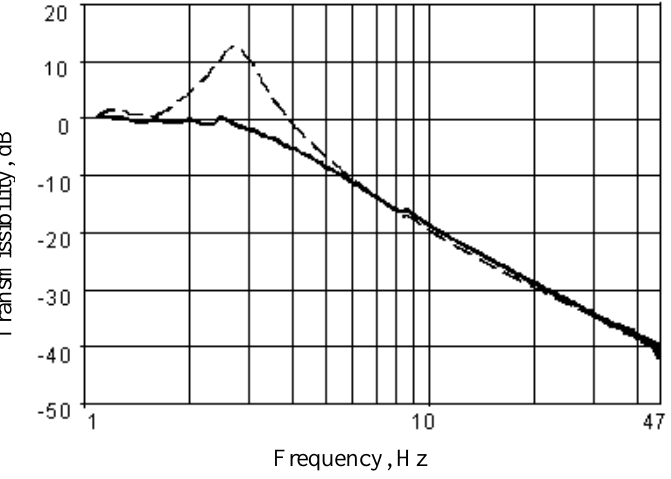
Fig. 9. Transmissibility of the pneumatic workstation with add-on active dampers. Dashed line – dampers off, solid line – dampers